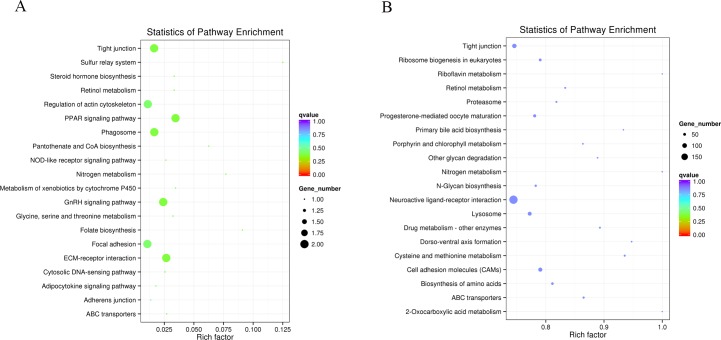
A. Scatterplot of KEGG enrichment for differentially expressed genes. B. Scatterplot of top 20 KEGG enrichment for target genes. Note: Rich factor is the ratio of the differentially expressed gene number or target number to the total gene number in certain pathway. The size and color of the dots represent the gene number and the range of the q value, respectively.